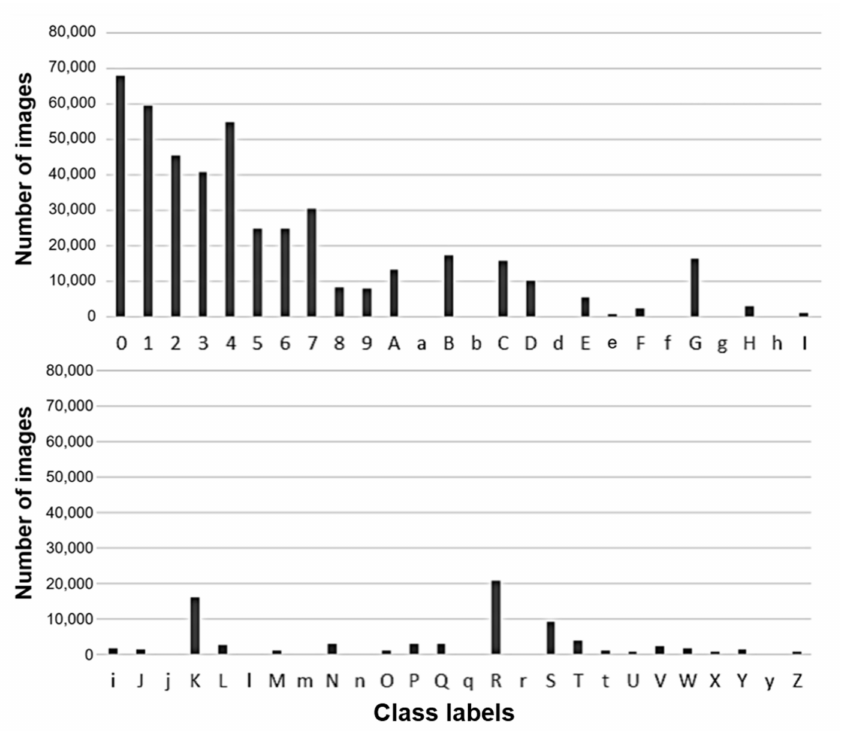
Figure 4. Data distribution by collected character class.